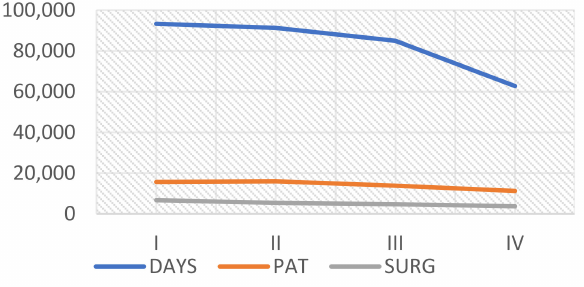
Figure 5. Mean hospital size measurements according to climate zones.